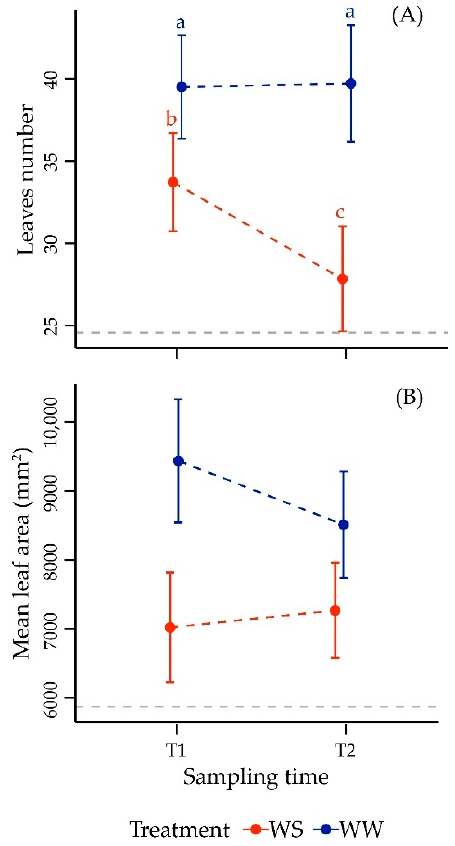
Figure 2. Mean values ± standard deviation of leaves number (panel A ), and mean leaf area (panel B ) in Merlot vines under well-watered (WW) and water stress (WS) conditions at sampling times T1 and T2 (237 and 260 DOY). The horizontal dotted line indicates the value of the variables at T0 (205 DOY). Different letters correspond to statistically significant differences ( p < 0.05).